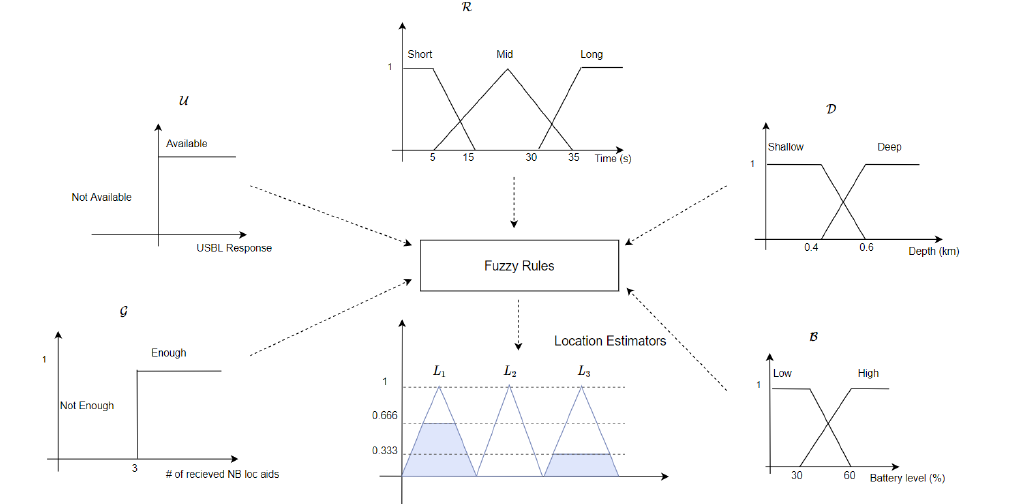
Figure 11. Fuzzy-based underwater localisation approach (Decision-making) with five variable inputs & their fuzzy/crisp sets and three underwater location estimators. The aggregated fuzzy output shows an example of a final localisation plan of ( 2